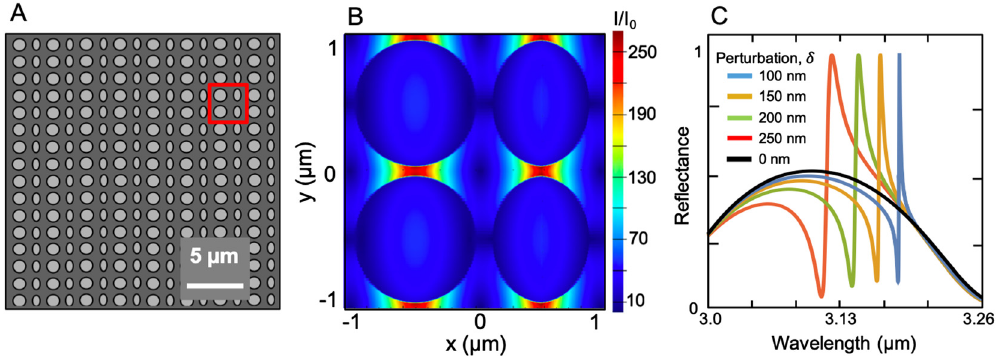
Figure 5: 2D dimerized high-contrast grating (DHCG) simulation. (A) Proposed 2D DHCG. The height of the grating is 250 nm, disk radii is 500 nm, and the period is 2.1 μ m. The dimerizing perturbation is to every other disk ’ s minor axis. (B) FDTD simulation showing the relative power enhancement in the region marked by a red square in (A) (top view). The strong fi eld con fi nement mode is entirely contained in the Argon gas region, with no leakage into the walls of the grating or substrate (C) Simulated polarized re fl ectance spectrum of 2D DHCGs with alternating minor axes of 500 nm – δ for four magnitudes of the perturbationaswellastheunperturbedcase.There fl ectancepeaksattheBICFanoresonancewavelengthnear3.15 μ m.Smallerperturbations correspond to larger Q -factors and narrower linewidths. FDTD, fi nite-difference time-domain; BIC, bound states in the continuum.